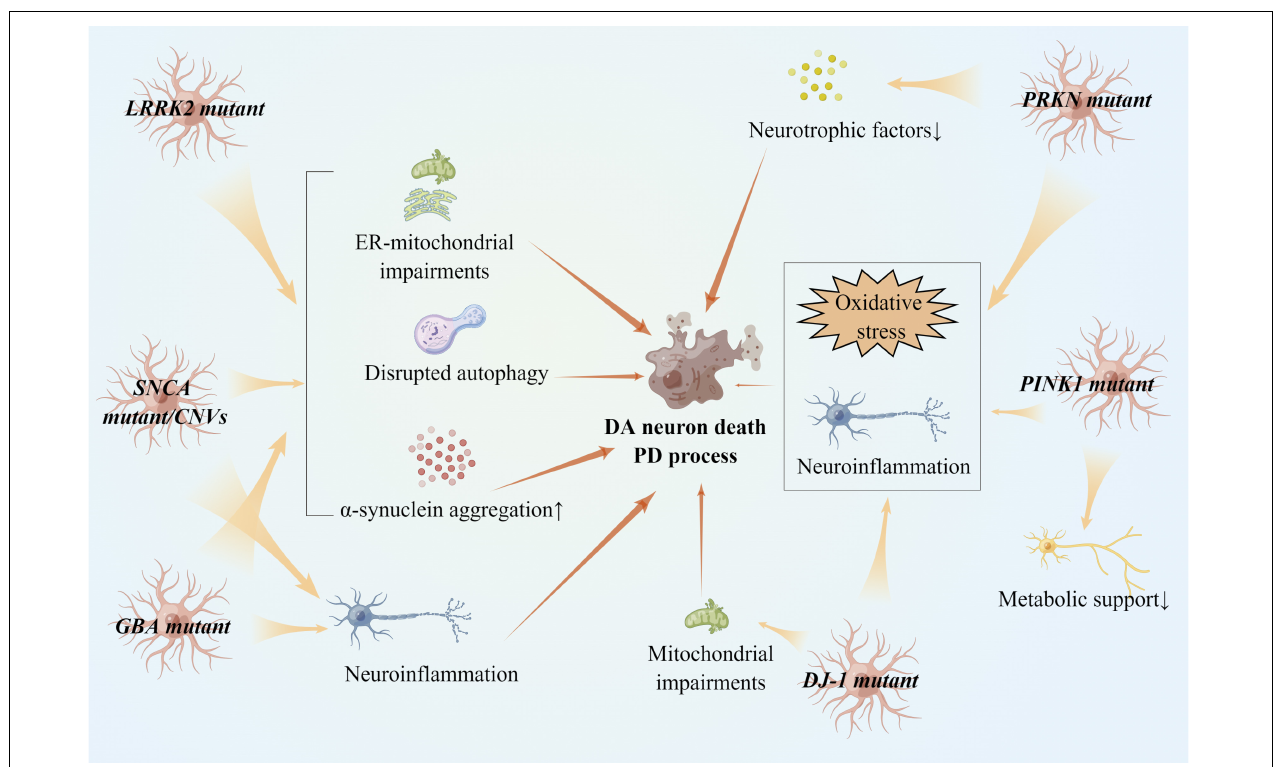
FIGURE 4 | Reactive astrocytes in gene variants of PD and PD pathogenesis. LRRK2 , SNCA , and GBA variants impaired ER-mitochondria in astrocytes, accelerating α -synucleins aggregation in dopaminergic neurons. SNCA and GBA variants also cause neuroinflammation in astrocytes. PRKN , PINK1 , and DJ-1 loss of functions induces oxidative stress in astrocytes and promote dopaminergic neuron death. Astrocytes lacking PRKN and PINK1 provide less metabolic support to